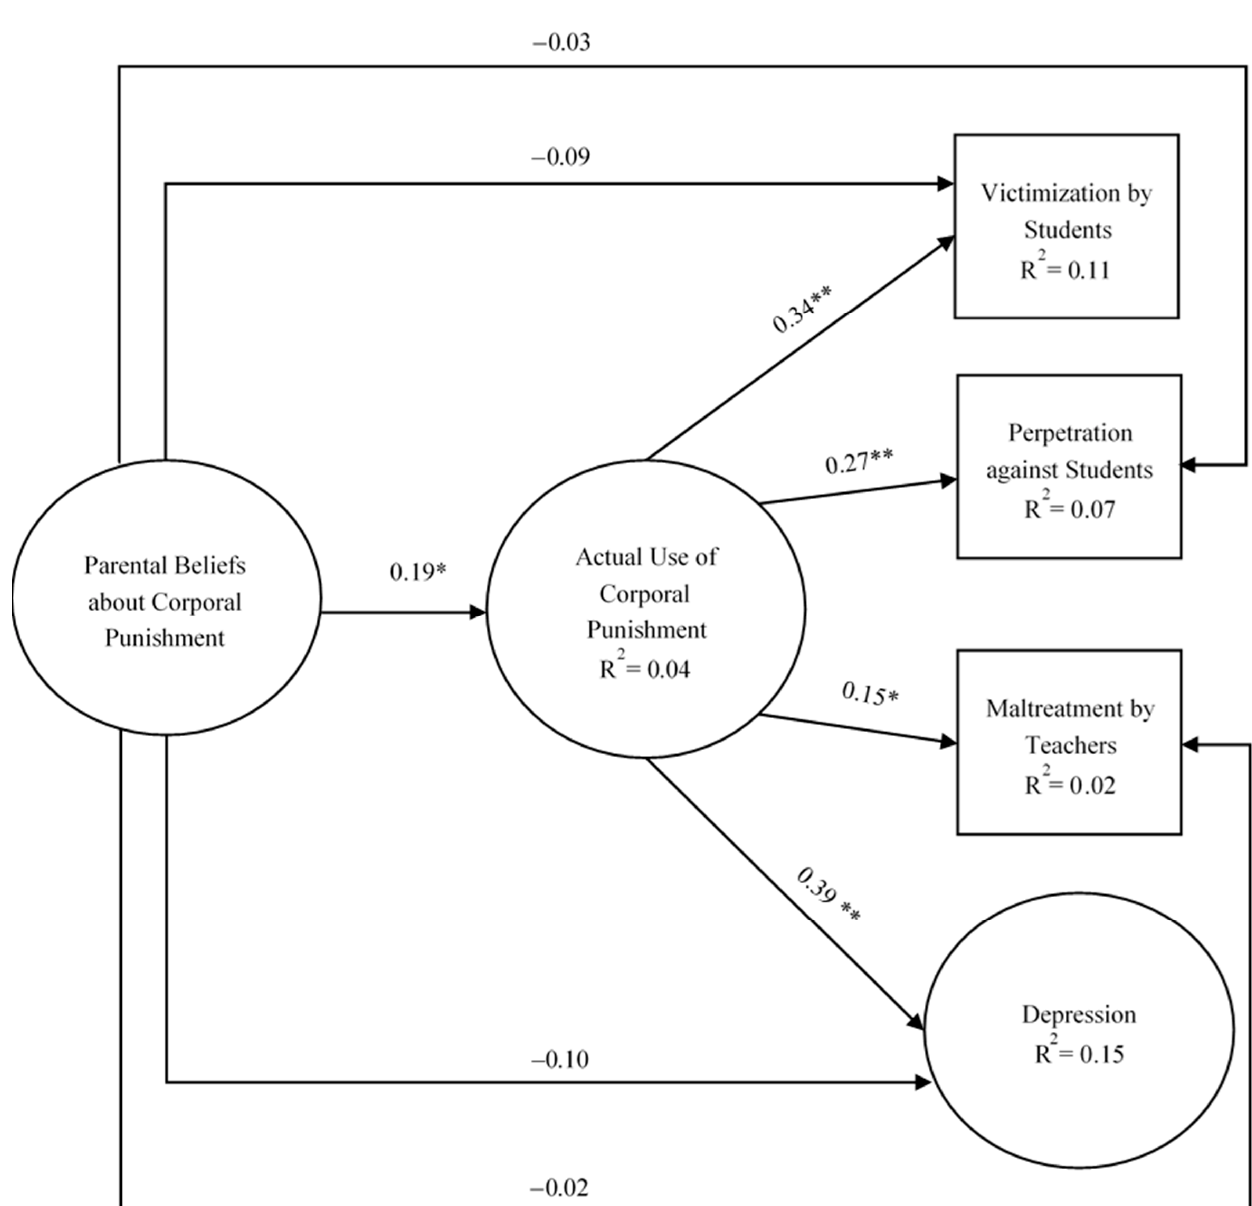
Figure 1. Overall model. Note. ** p < 0.001; * p < 0.01.